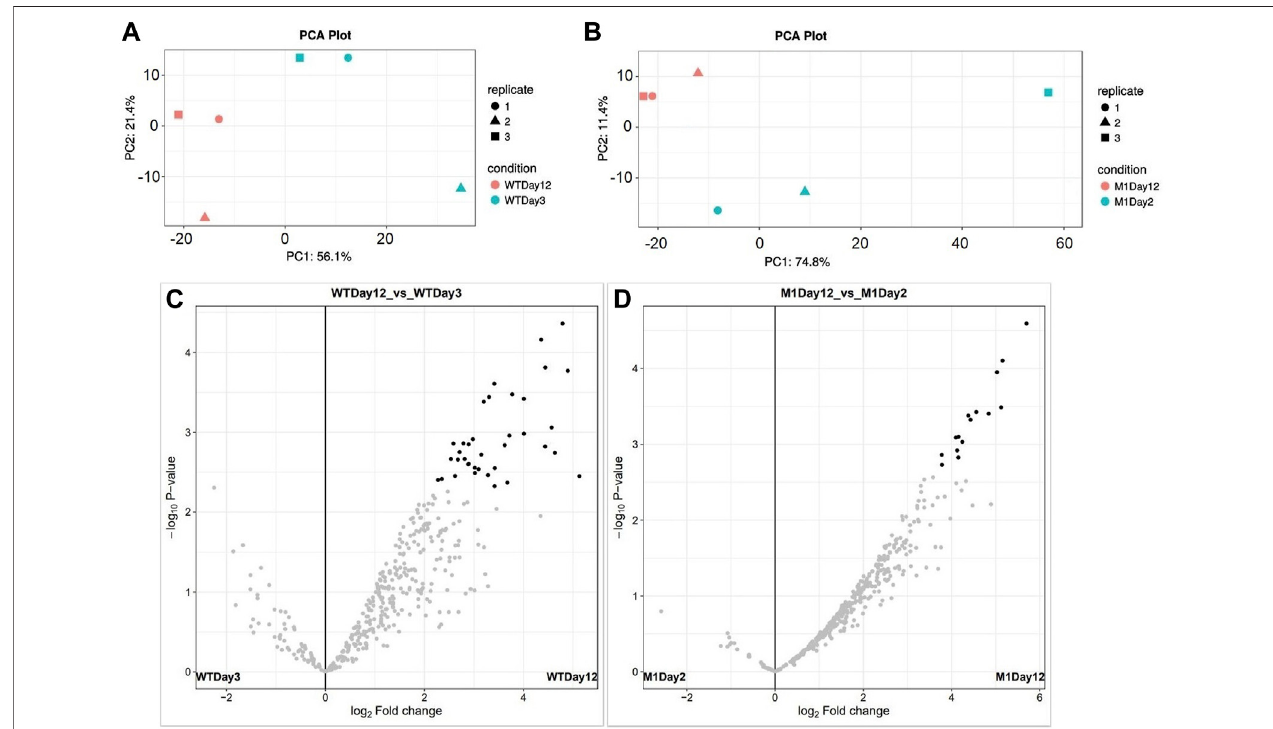
FIGURE6| PCA plots show 12samples clustered bybiological replicates: (A) Wild-type N.oculata samplesday 3(light blue)and day 12(pink)and (B) M1 mutant N. oculata samples day 2 (light blue) and day 12 (pink). Volcano plots show the signi fi cant protein distributions in wild-type (C) and M1 mutant (D) N. oculata